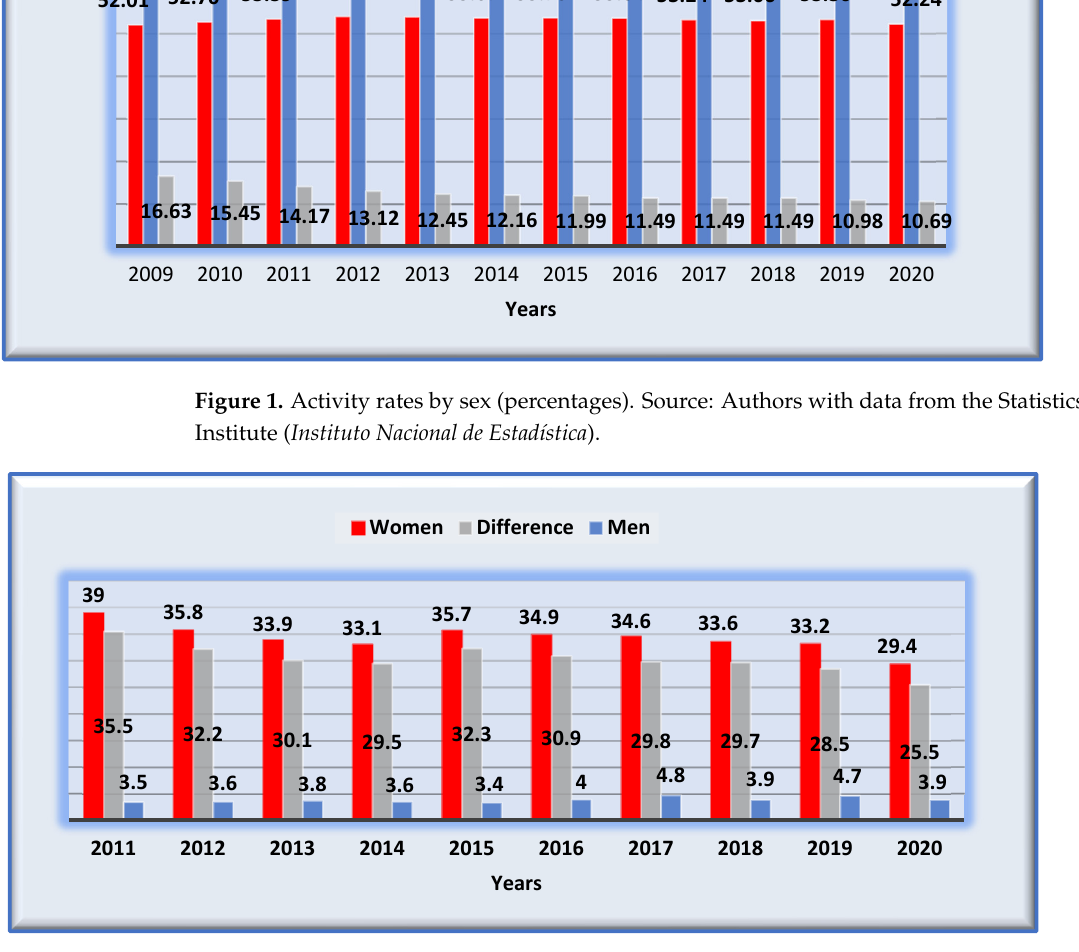
Figure 2. Inactive population in Spain from 15 to 64 years not seeking employment. Reason: care of adults with disabilities or children and other family or personal motives (percentages). Source: Authors with data from EUROSTAT (available at: http://appsso.eurostat.ec.europa.eu/nui/show.do?dataset=lfsa_igar&lang=en (accessed on 23 September